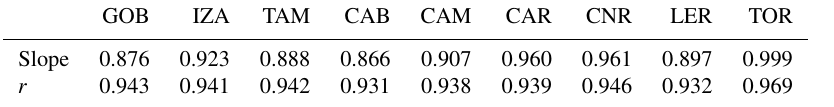
Table 2. RTM-simulated GHI at 15min time intervals as compared to the BSRN ground-based measurements in terms of correlation coeffi- cient ( r ) and slope.